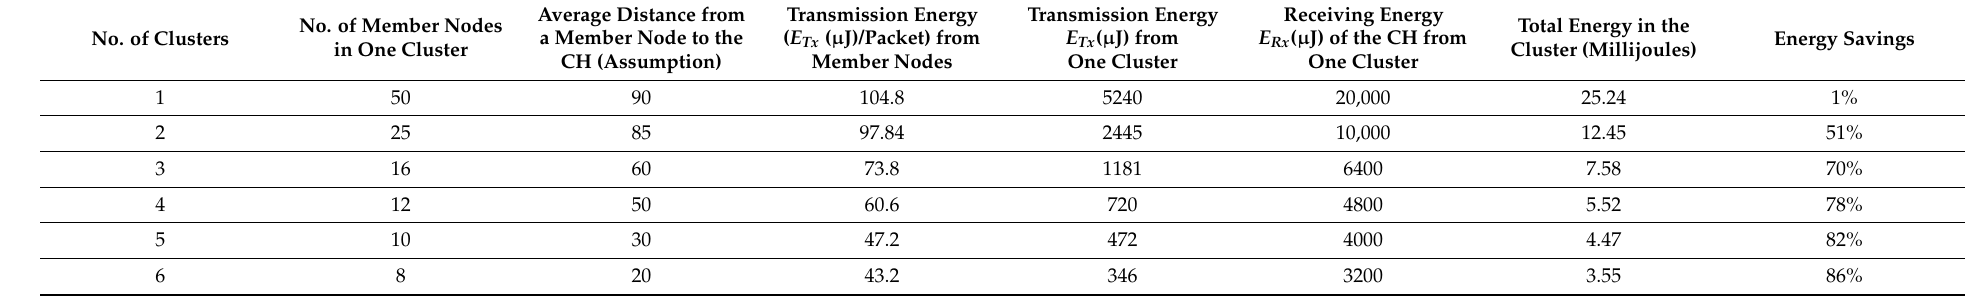
Table 7. Energy calculation of intra-cluster communications.